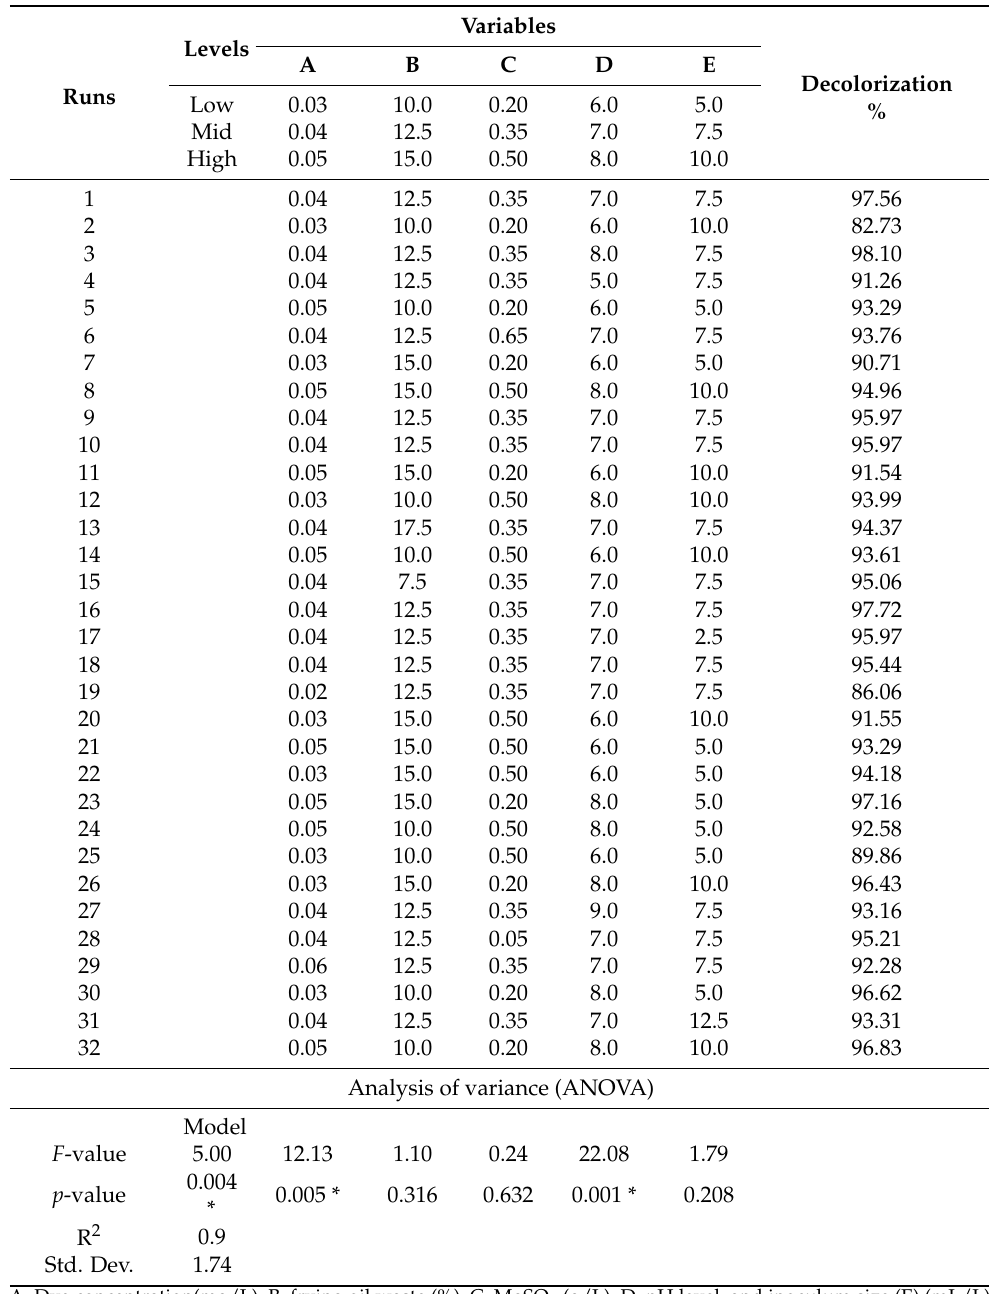
Table 1. CCD matrix and ANOVA analysis against MG decolorization by S. exfoliatus